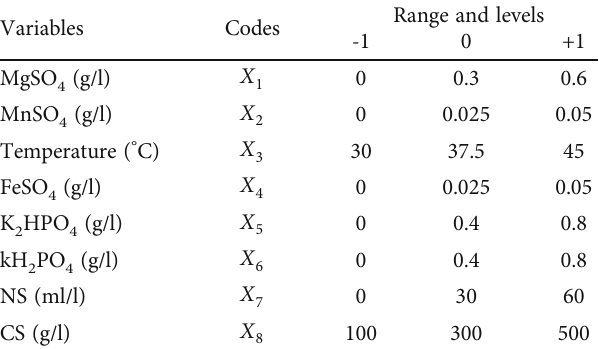
Table 1: Real levels of variables used in de fi nitive plan.